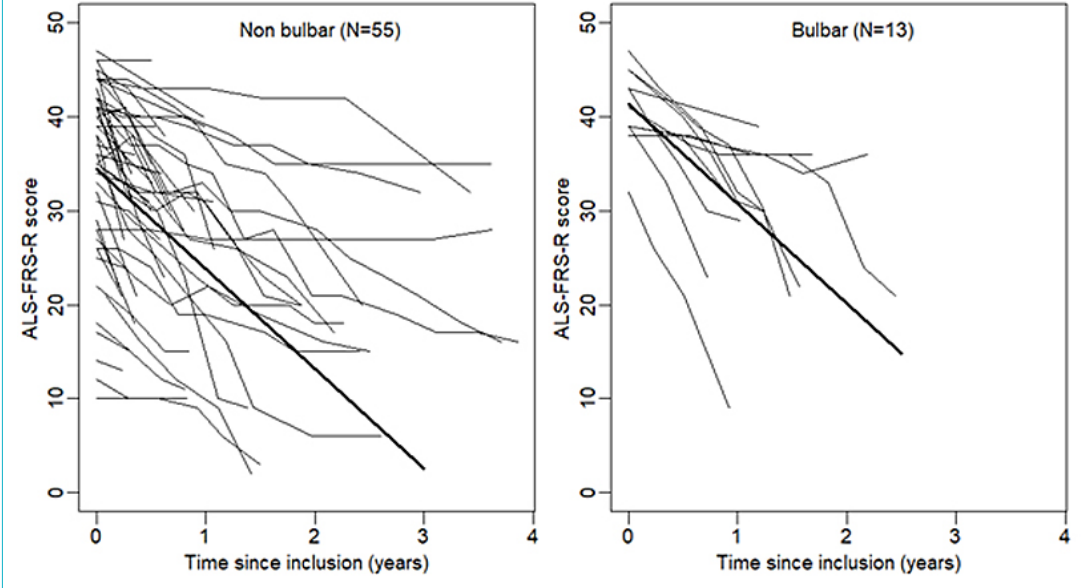
Figure S1: Evolution of ALS-FRS-R scores during follow-up in patients with bulbar (n = 13, 19%) and non-bulbar (n = 55, 81%) onset of ALS: rate of decline did not differ significantly between the two